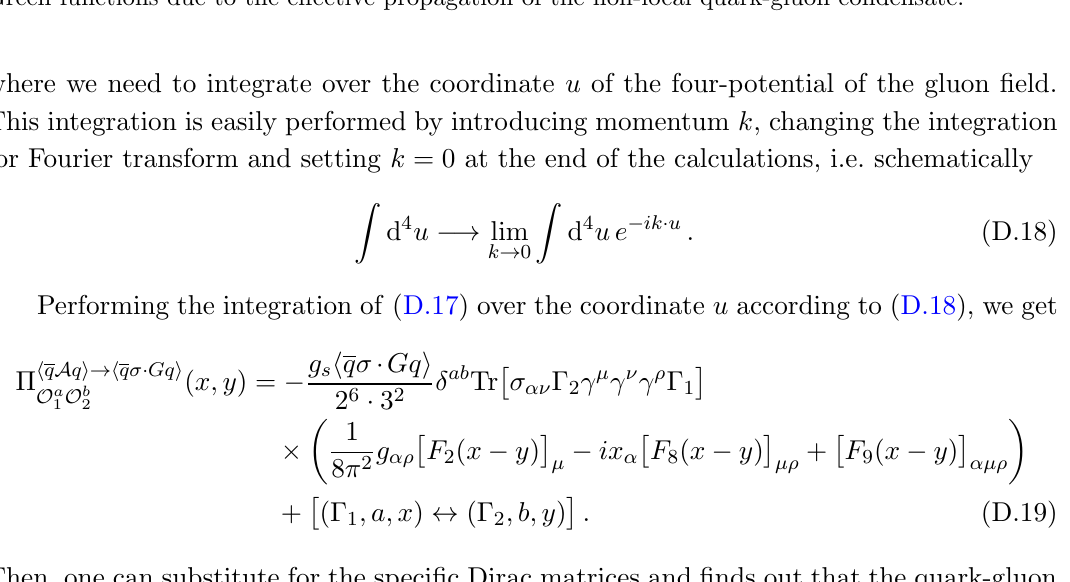
Figure 15. Feynman diagram of the contribution of the quark-gluon condensate to the two-point Green functions due to the e(cid:11)ective propagation of the non-local quark-gluon